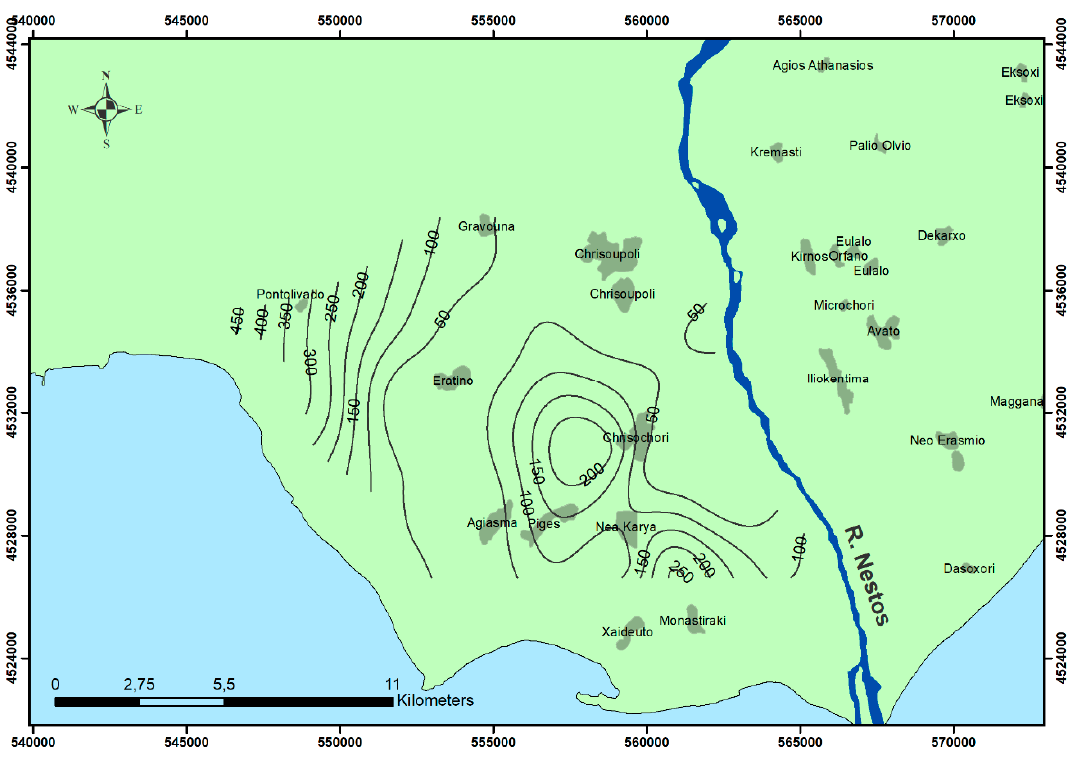
Figure 16. Chloride ion (Cl − ) distribution map (mg/L) of the confined aquifer (October 2019).